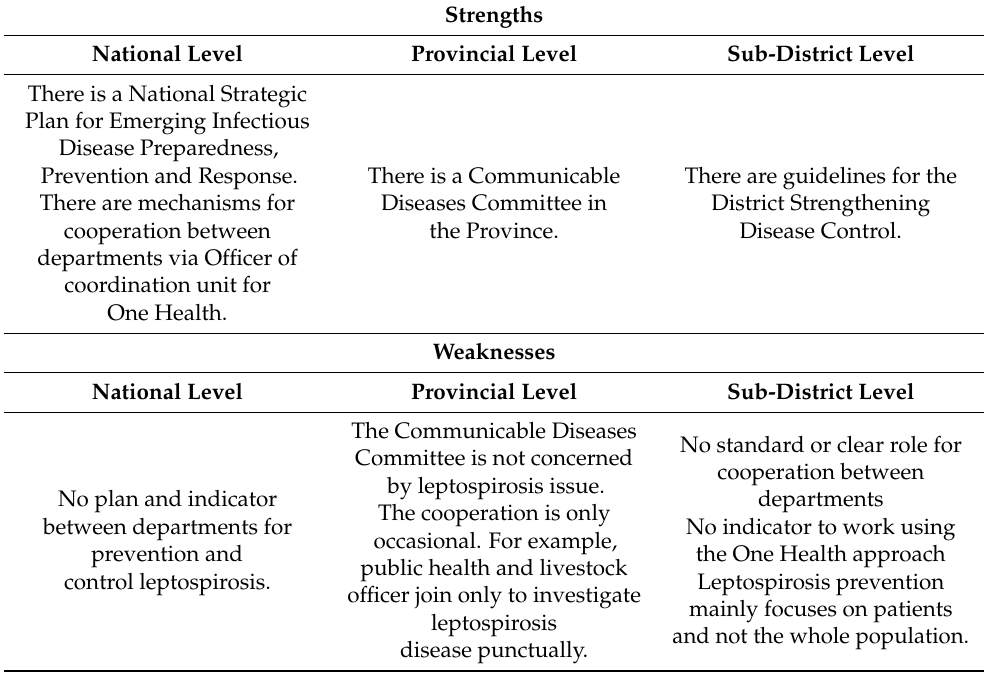
Table 3. Strengths and weaknesses in leptospirosis prevention and control policy